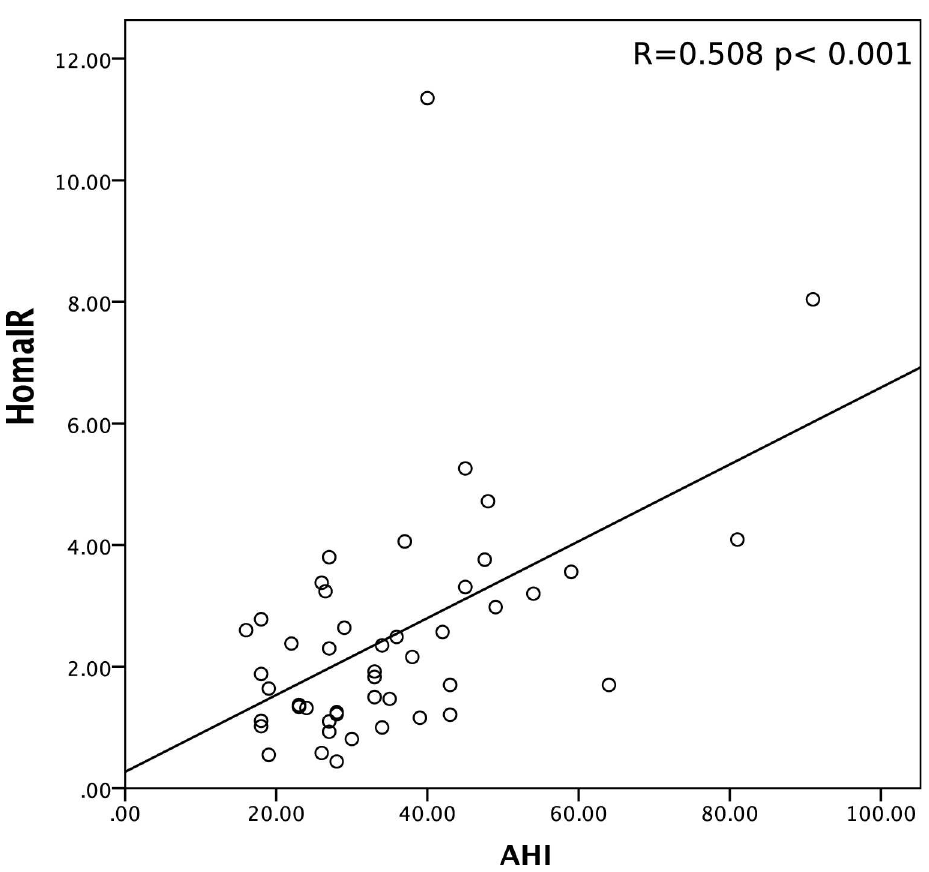
Fig 1. Scatter plot of apnea–hypopnea index (AHI) and HOMA-IR in OSA group.